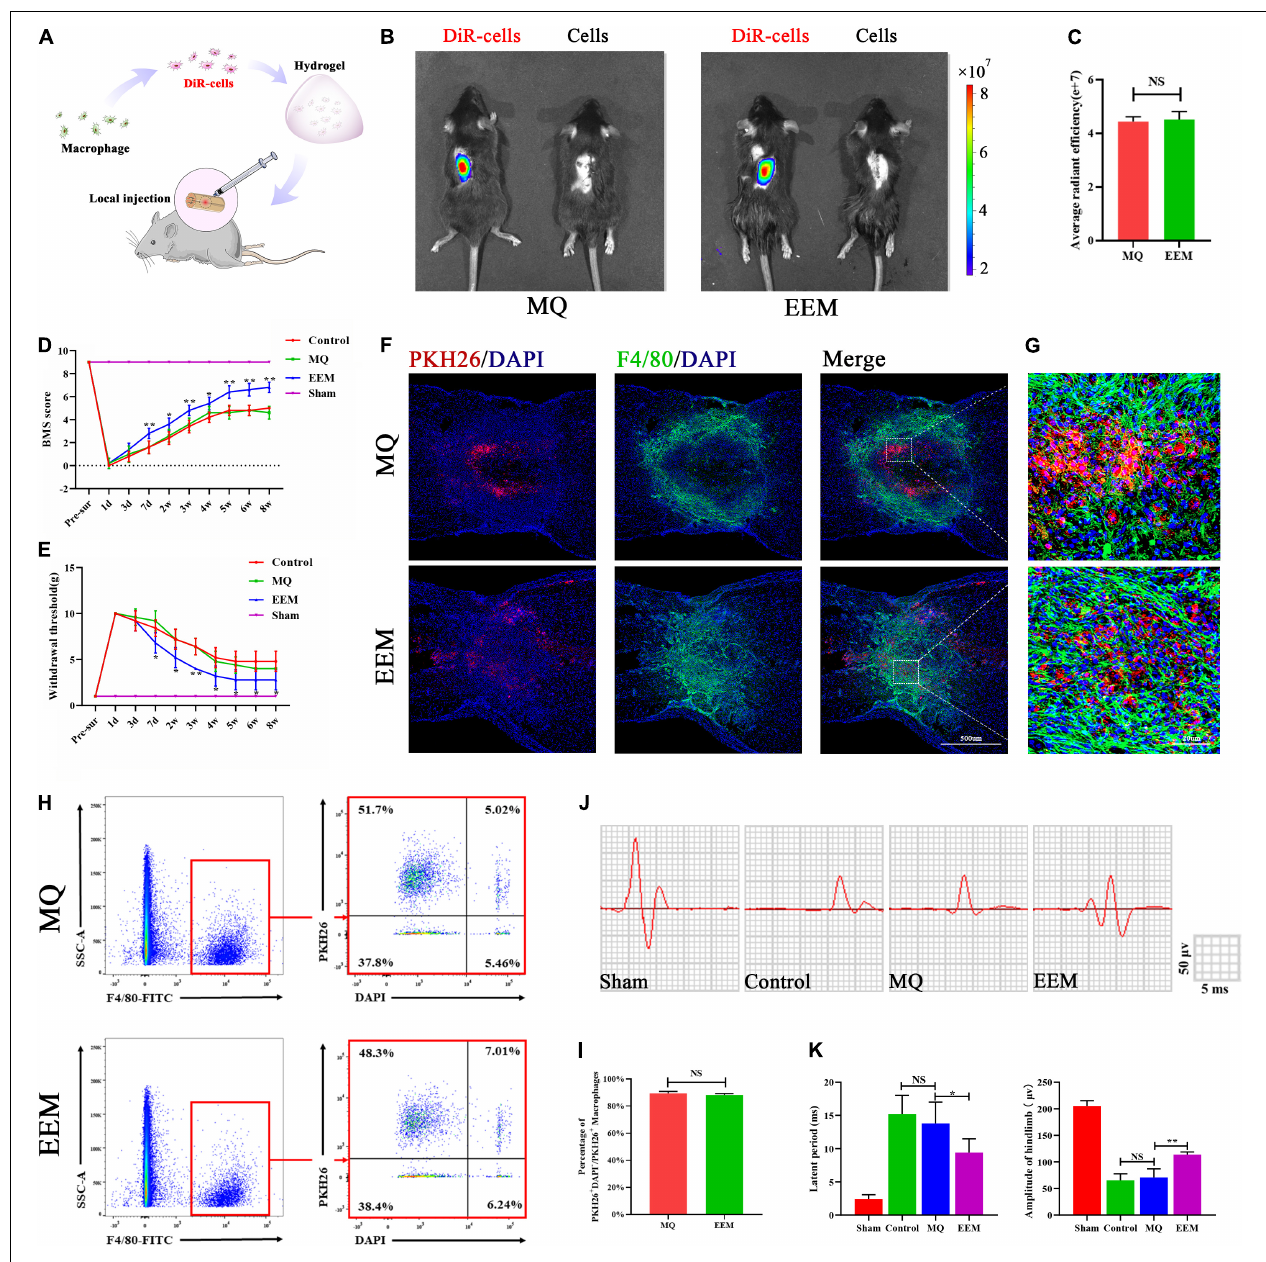
FIGURE 4 | EEM promote sensory and motor functional recovery after SCI. (A) Schematic depiction of the approaches used to transplant the DiR-labeled EEM or MQ. (B) In vivo tracing of the distribution of DiR-labeled EEM and MQ embedded in hydrogels in the injured spinal cord at 3 days. (C) Quantification of average fluorescence efficiency of (B) ( t = 0.40, p = 0.54, n = 3 animals per group). (D) BMS scores after SCI in the different treatment groups [ F (3, 16) = 586.4, p < 0.01. Tukey’s post hoc test. MQ vs. EEM (1d), p = 0.99; MQ vs. EEM (3d), p = 0.75; MQ vs. EEM (7d), p < 0.01; MQ vs. EEM (2w), p < 0.05; MQ vs. EEM (3w), p < 0.01; MQ vs. EEM (4w), p < 0.05; MQ vs. EEM (5w), p < 0.01; MQ vs. EEM (6w), p < 0.01; MQ vs. EEM (8w), p < 0.01; n = 5 animals for each group]. (E) The hind paw withdrawal thresholds in response to mechanical stimulation after SCI in the different treatment groups [ F (3, 16) = 169.4, p < 0.01. Tukey’s post hoc test. MQ vs. EEM (1d), p = 0.99; MQ vs. EEM (3d), p = 0.54; MQ vs. EEM (7d), p < 0.01; MQ vs. EEM (2w), p < 0.05; MQ vs. EEM (3w), p < 0.01; MQ vs. EEM (4w), p < 0.05; MQ vs. EEM (5w), p < 0.05; MQ vs. EEM (6w), p < 0.05; MQ vs. EEM (8w), p < 0.05; n = 5 animals for each group]. (F) Immunofluorescence tracing of PKH26-labeled EEM or MQ in the injured spinal cord at the T10 spinal segment area: F4/80 (green), PKH26 (red), nuclei DAPI (blue). Scale bar: 200 µ m. n = 3 animals per group. (G) Magnification of (F) . (H) Survival rate of transplanted EEM and MQ by flow cytometry. (I) Percentages of PKH26 + DAPI - /PKH26 + cells of (H) ( t = 1.08, p = 0.62; n = 3 animals per group). (J) Representative electrophysiological traces in the different treatment groups. (K) Quantification of the amplitude and latency period of MEPs in the different treatment groups [latent period: F (3, 16) = 44.20, p < 0.01. Tukey’s post hoc test. Control vs. MQ, p = 0.67; MQ vs. EEM, p < 0.05; amplitude of hindlimb: F (3, 16) = 236.8, p < 0.01. Tukey’s post hoc test. Control vs. MQ, p = 0.81; MQ vs. EEM, p < 0.01; n = 5 animals for each group]. The data are presented as the means ± SD. * p < 0.05, ** p < 0.01, NS = Not significant.